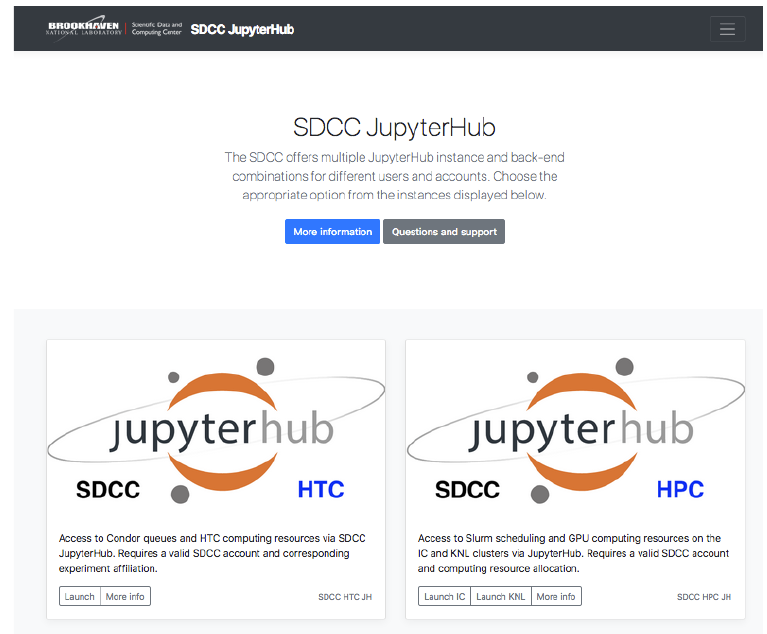
Figure 2. SDCC Analysis Portal front-end interface to load-balancing proxy, showing HTC and HPC